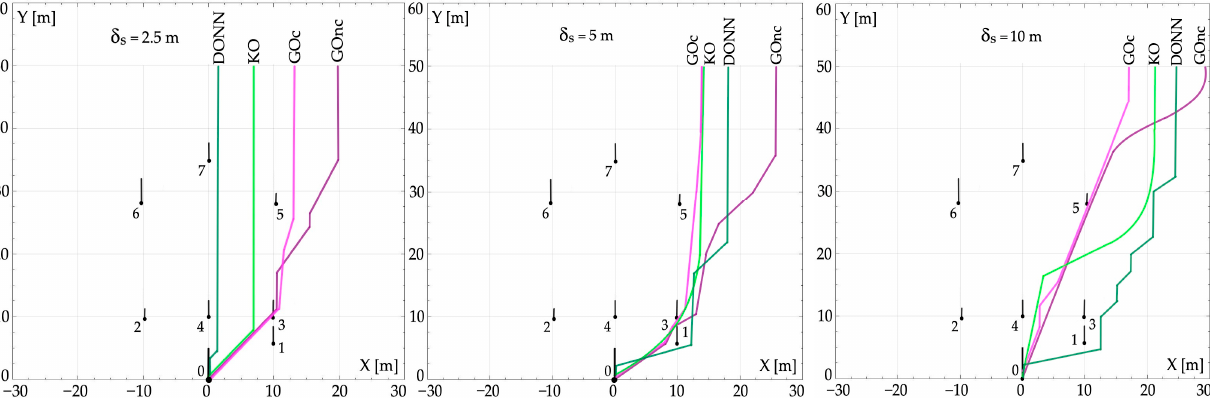
Figure 17. Comparison of the determined trajectories of the autonomous vehicles in one-way traffic according to the KO, DONN, and GO algorithms for three safe passing distance values.